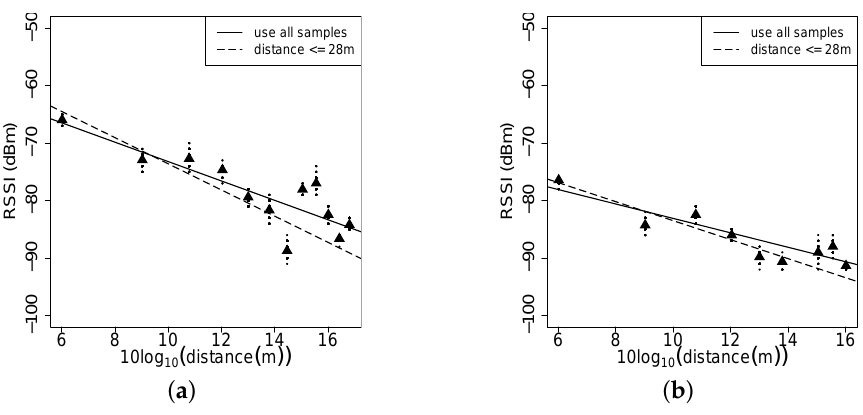
Figure 12. RSSI distance fitting in the Bajia forest environment. ( a ) tx = 31; ( b ) tx =